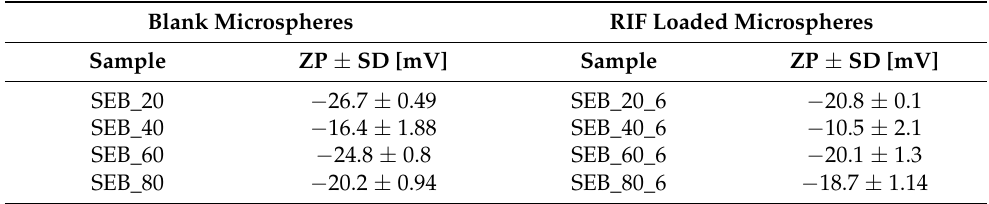
Figure 9. FT-IR spectra of rifampicin ( A ), copolymer ( B ) and rifampicin-loaded microspheres ( C ).